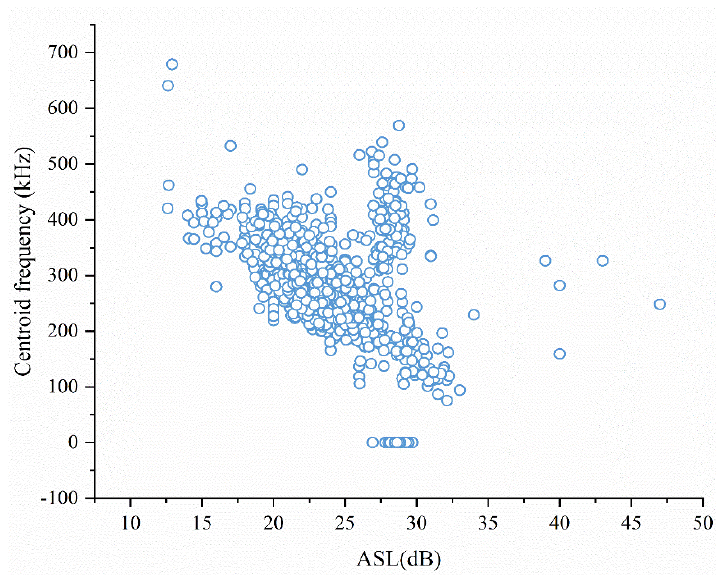
Figure 27. ASL-centroid frequency correlation diagram of Caihong Bridge.